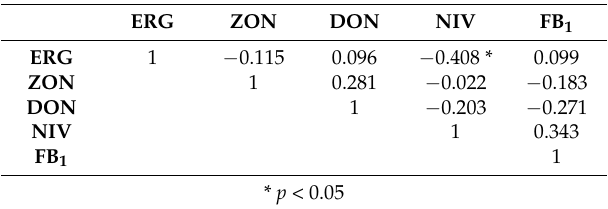
Table 5. Correlations between ergosterol and particular